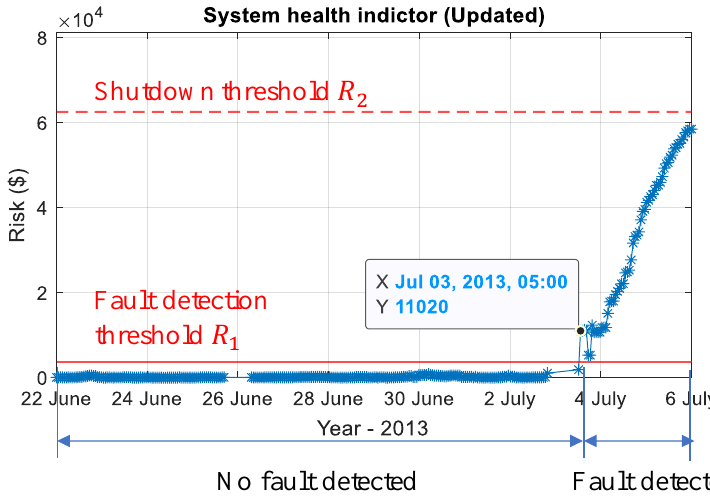
Figure 12. System health indicator presented by risk profile of the pump.